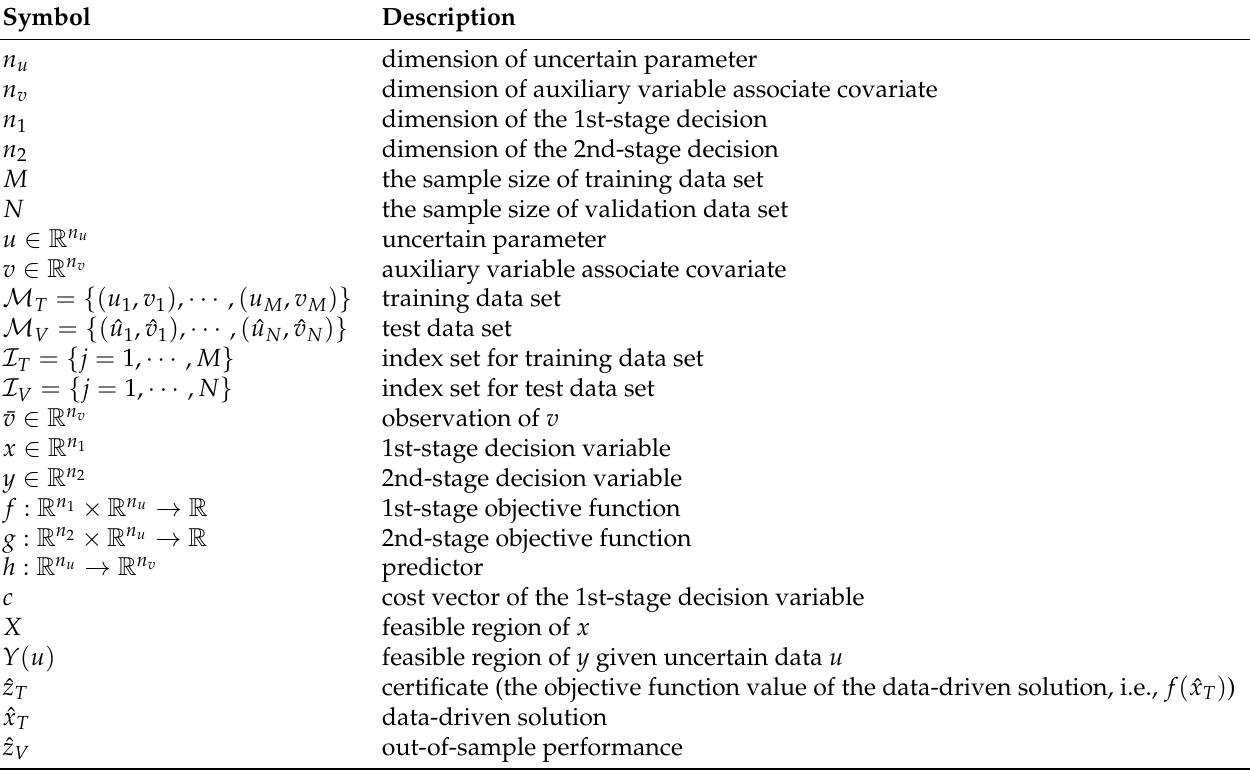
Table 1. Summary of